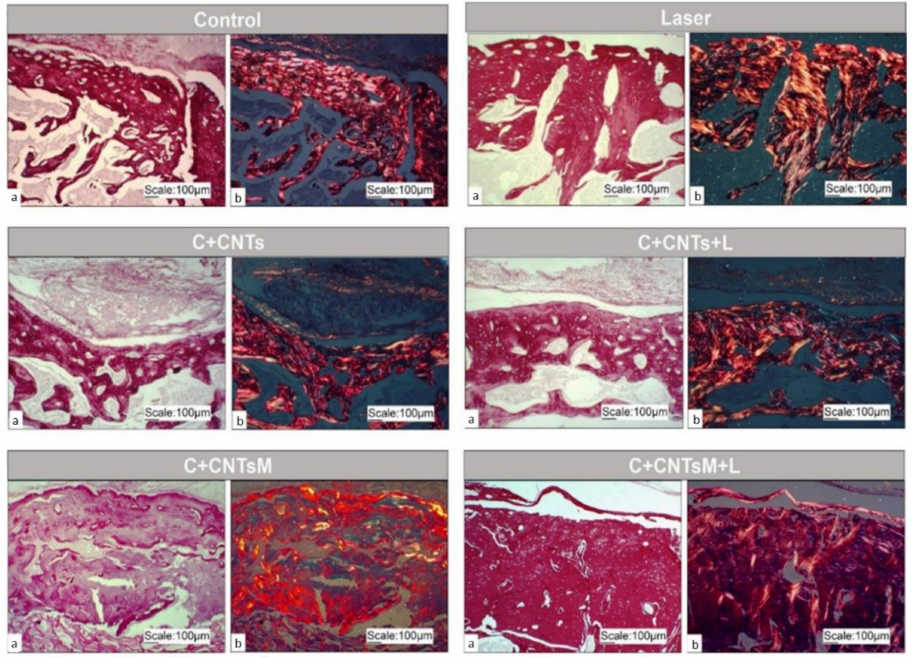
Figure 7. Picrosirius red optical microscope images in optical light ( a ) and respective polarized light ( b ) of the study groups, 10 × magnification. Birefringence of the extracellular matrix is observed in the area of the bone